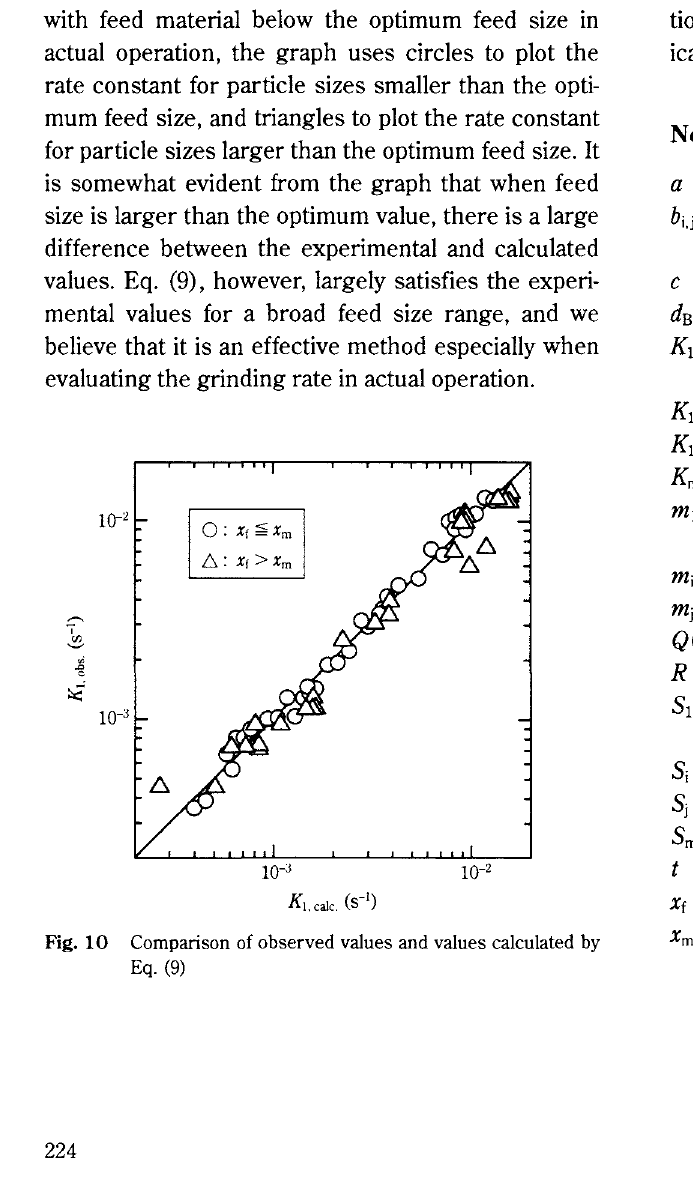
Fig. 10 Comparison of observed values and values calculated by Eq.